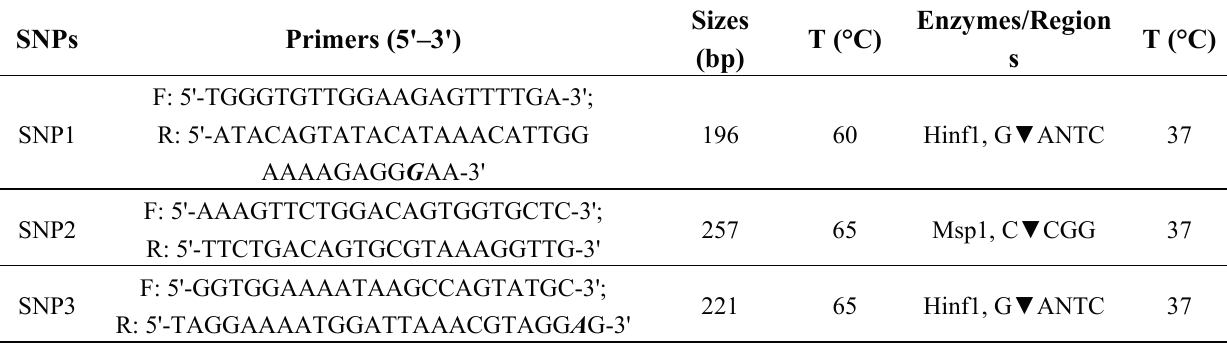
Table 3. Primers used to identify genetic variants of the AUTS2